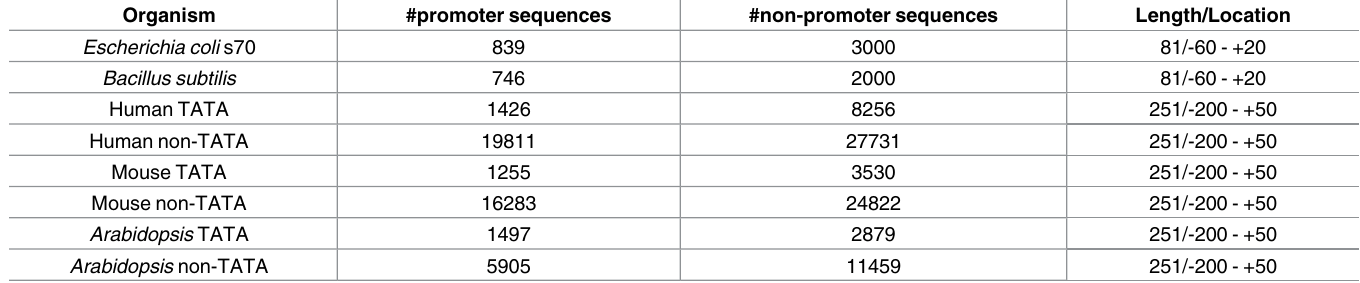
Table 1. Numbers, lengths and locations of promoter and non-promoter sequences for studied organisms. Locationsare given relative to the TSS (Transcription Start Site) position.